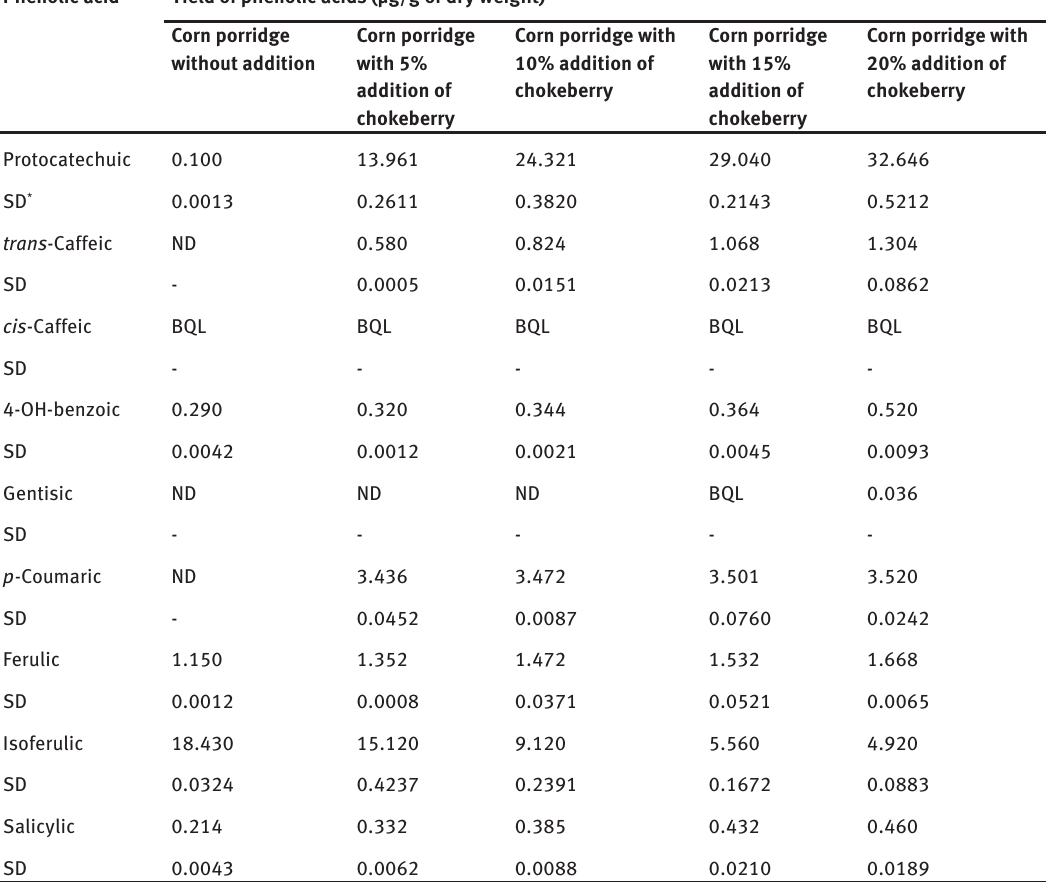
Table 4: Content of phenolic acids . Phenolic acid Yield of phenolic acids (µg/g of dry